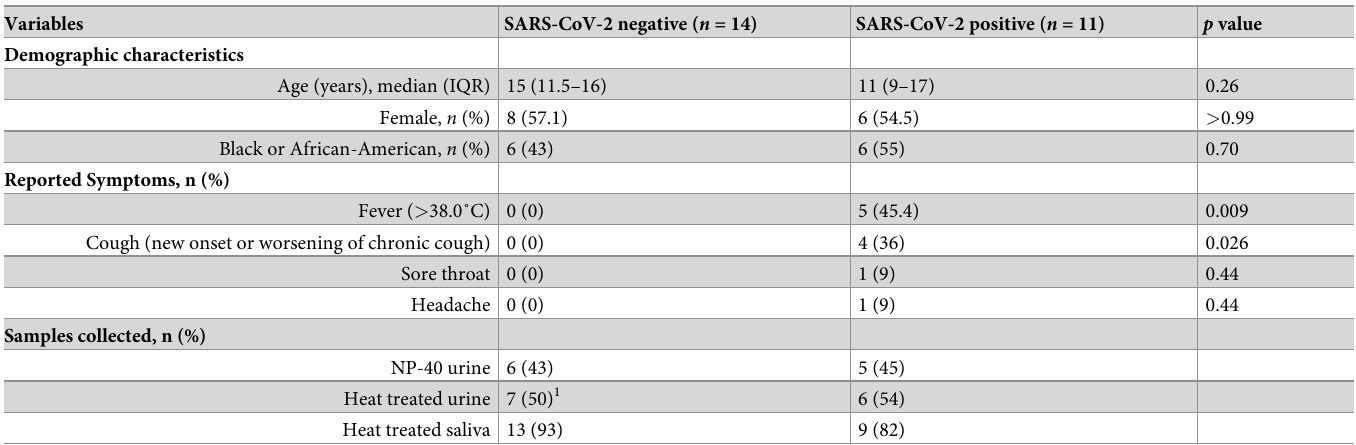
Table 2. Children’s demographic and clinical characteristics for urine and saliva samples. Variables Demographic